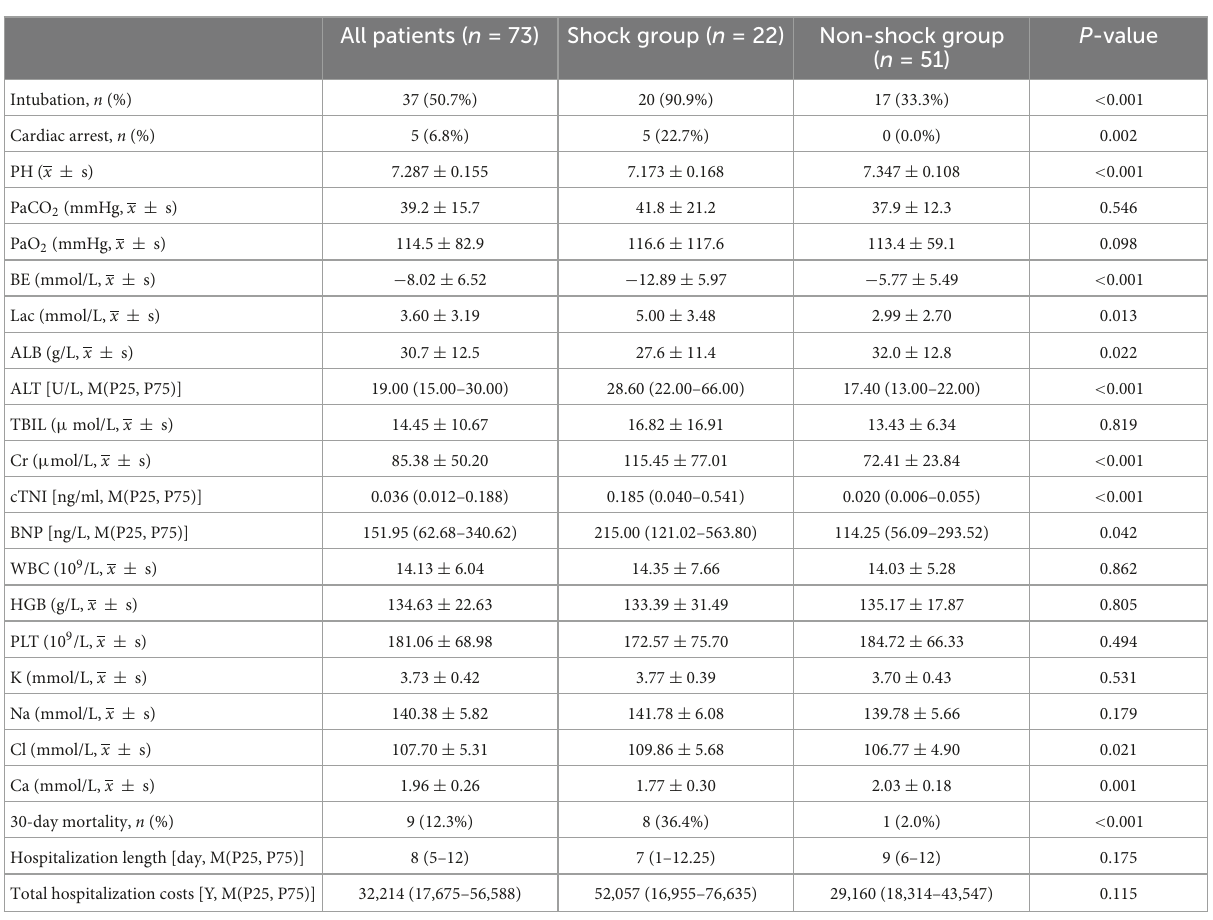
TABLE 2 Comparison of clinical indicators between shock group and no shock